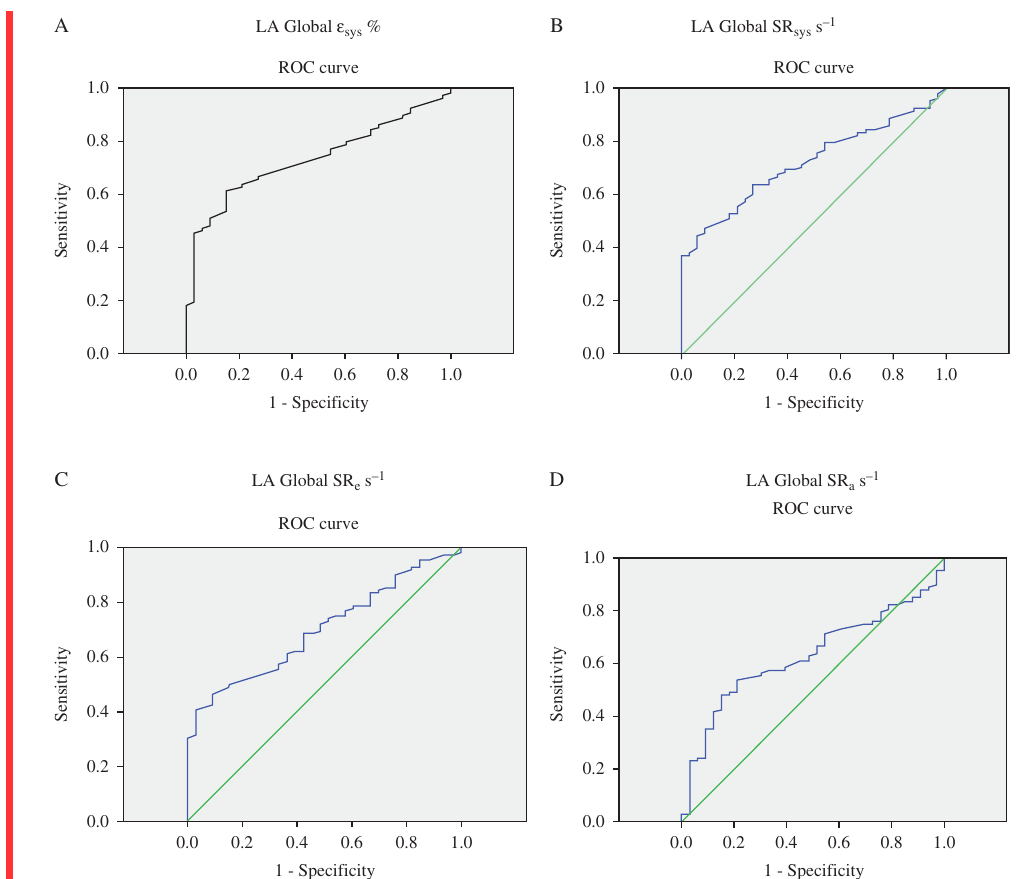
Figure 7. ROC curve of Global LA deformation parameters have been plotted for differentiating HCM patients with LA dysfunction. (A) LA e sys ; (B) LA SR sys ; (C); LA SR e ; (D) LA SR